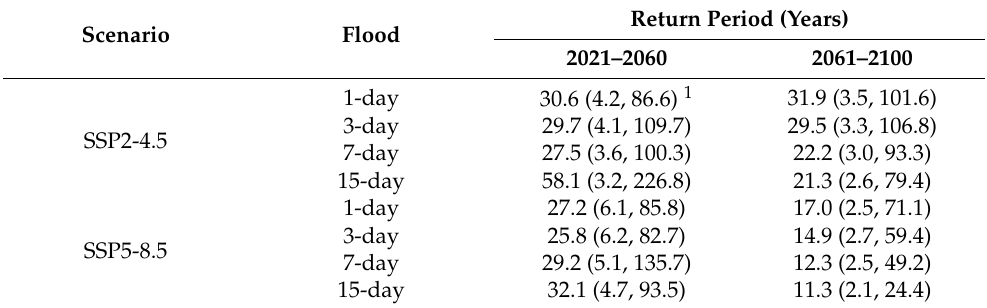
Table 4. Projected flood frequency with current (1971–2010) 30-year return value of 1-, 3-, 7-, and 15-day floods in the Fujiang River basin for 2021–2060 and 2061–2100 under 14 GCMs and 2 SSP-RCPs.